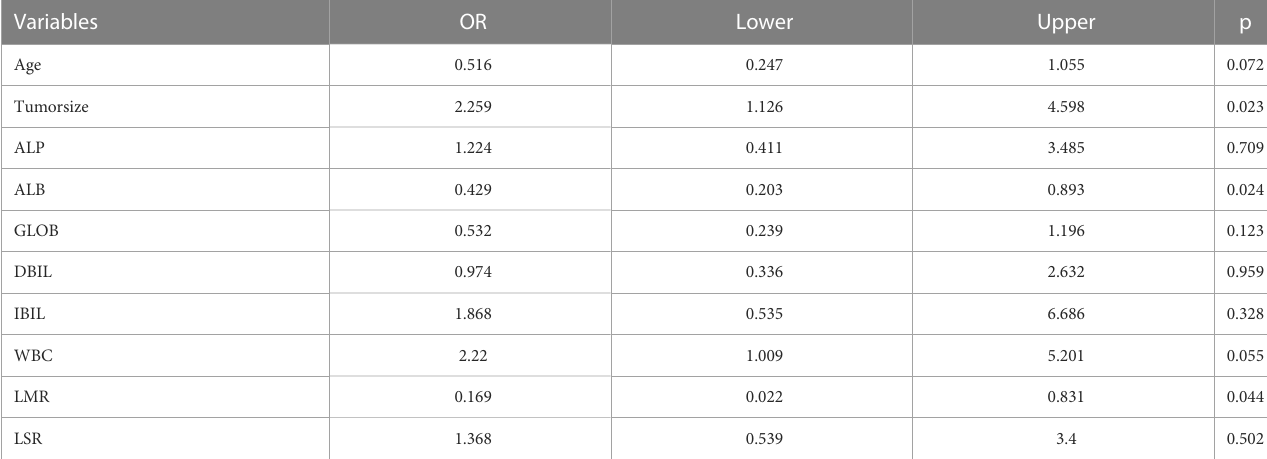
TABLE 3 Multivariate regression